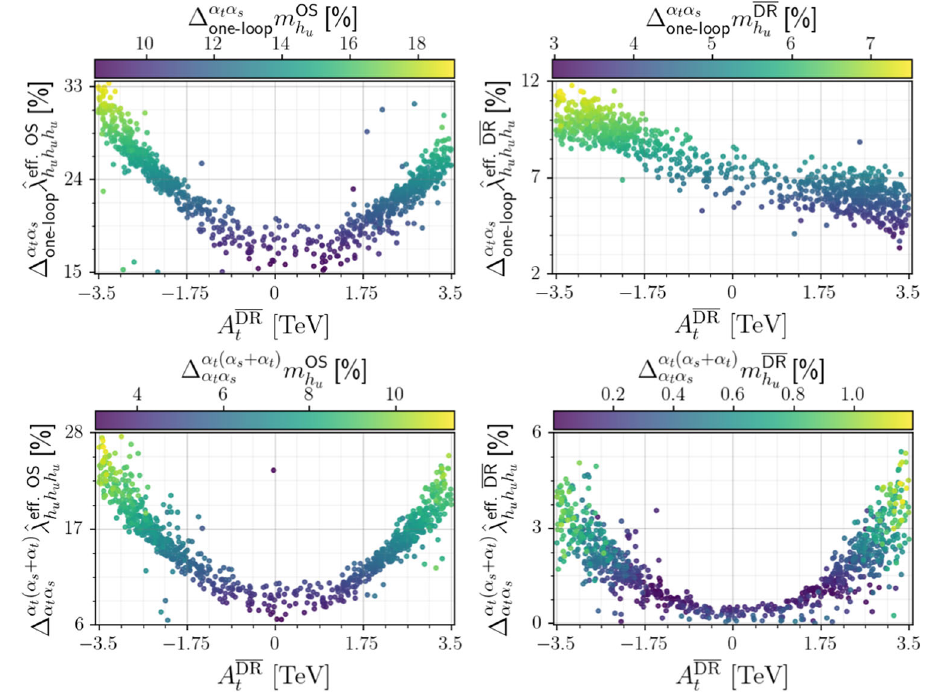
Fig. 6 Relative size of the loop-corrected effective trilinear Higgs self-coupling of the h u -like Higgs boson ˆ λ eff lower order in the OS (left) and the DR scheme (right) at O (α t α s )